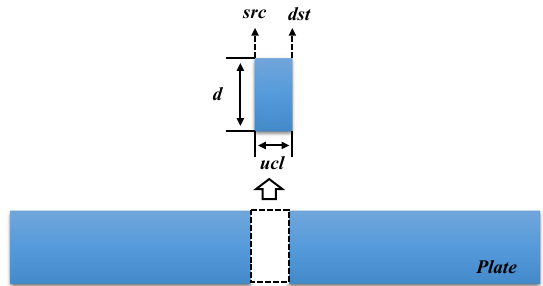
Figure 1 A unit cell in WFE based on F-B